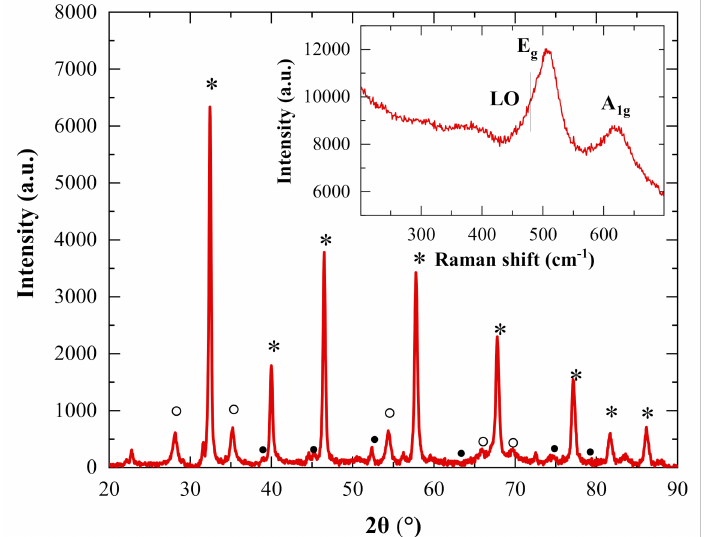
Figure 3. XRD pattern and Raman spectrum (inset) for SrTiO 3 :RuO 2 :NiO photocatalyst (0.8 wt. % of Ru; [Ru]:[Ni] molar ratio of 1:1). XRD diffraction peaks corresponding to either SrTiO 3 (*), RuO 2 ( ◦ ), and NiO ( • ).